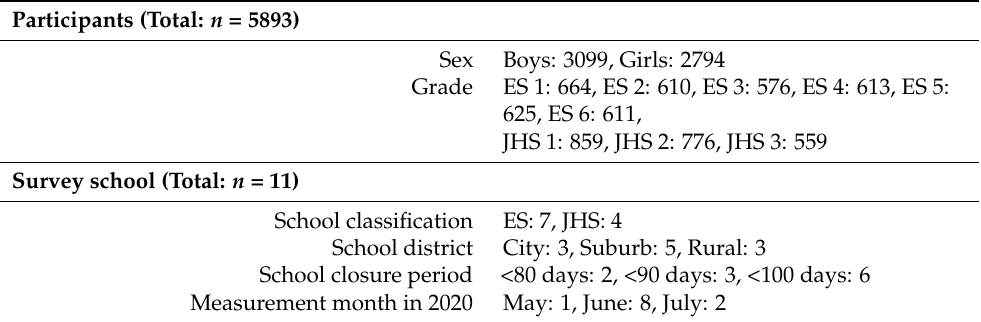
Table 1. Descriptive characteristics of participants and participating